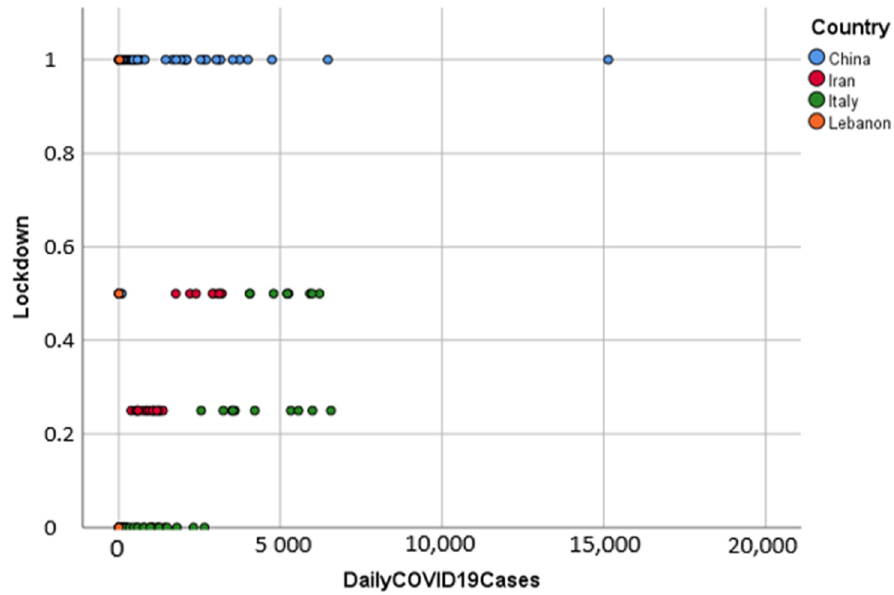
Figure 2. Grouped scatterplot of lockdown and daily covid-19 cases by country.